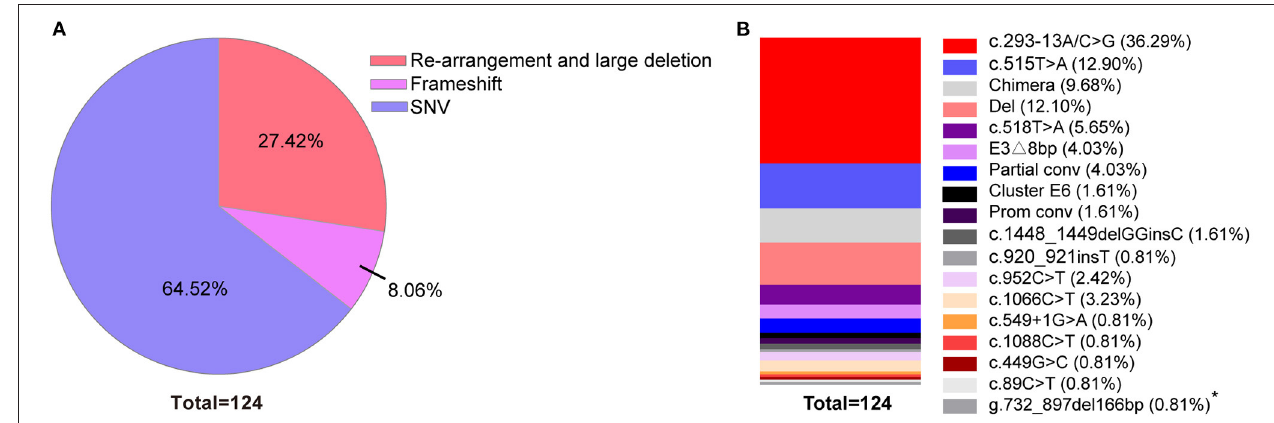
( Figure 1 ; Table 1 ). These observed trends further